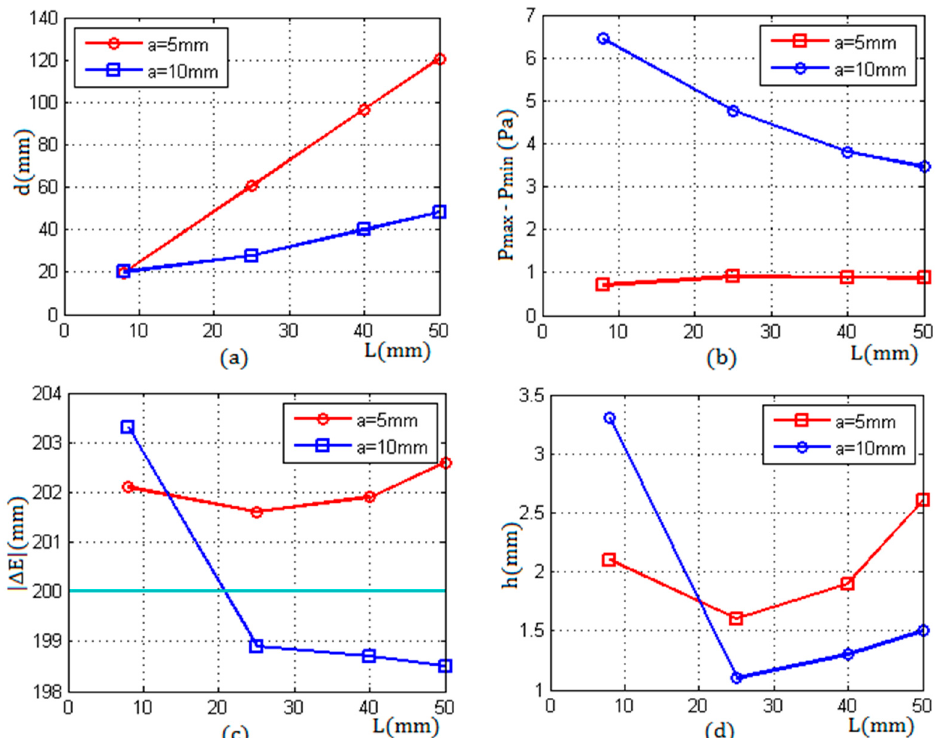
Figure 12. The experimental results taking water as an example: ( a ) the diameters of the transmitting beam cross section versus the wall thickness; ( b ) the difference of the echo sound pressure between the critical positions versus the wall thickness; ( c ) the measured liquid level versus the wall thickness; ( d ) the errors versus the wall thickness.